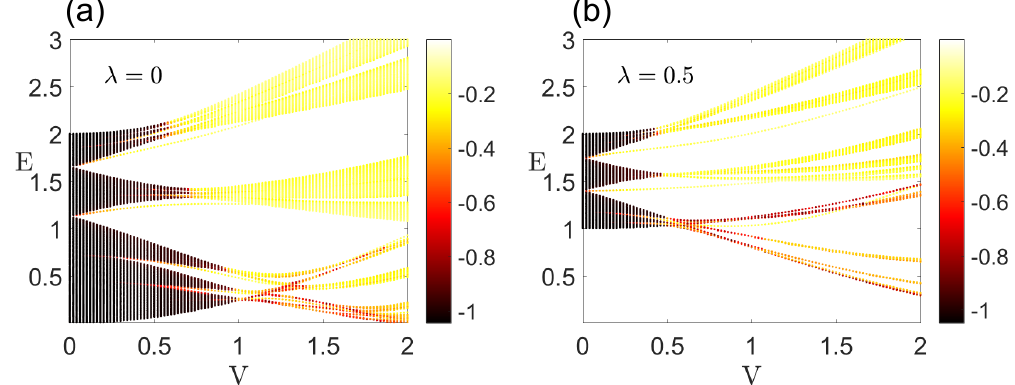
Figure 7: Opposite of the IPR scaling exponent, − τ = log ( IPR ) / log ( L ) , versus po- tential amplitude V and eigen energy E for the quasiperiodic SSH model of Eq. (7) in the main paper, with (a) λ = 0 and (b) λ =